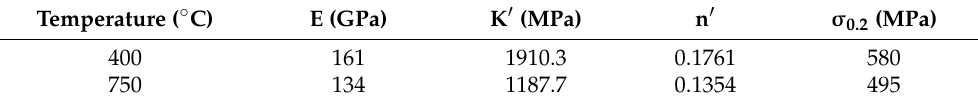
Table 1. Material constants of the Ramberg–Osgood model at different temperatures and σ 0.2 . Temperature (°C)